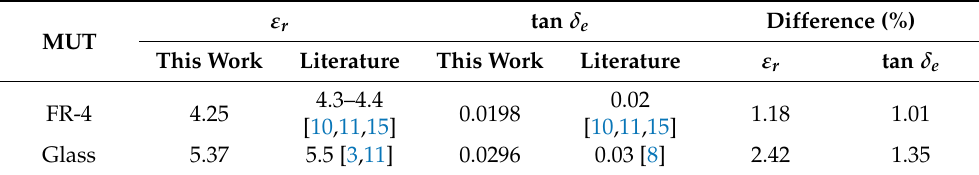
Table 3. This work dielectric constant and loss tangent results compared to those available in the literature.